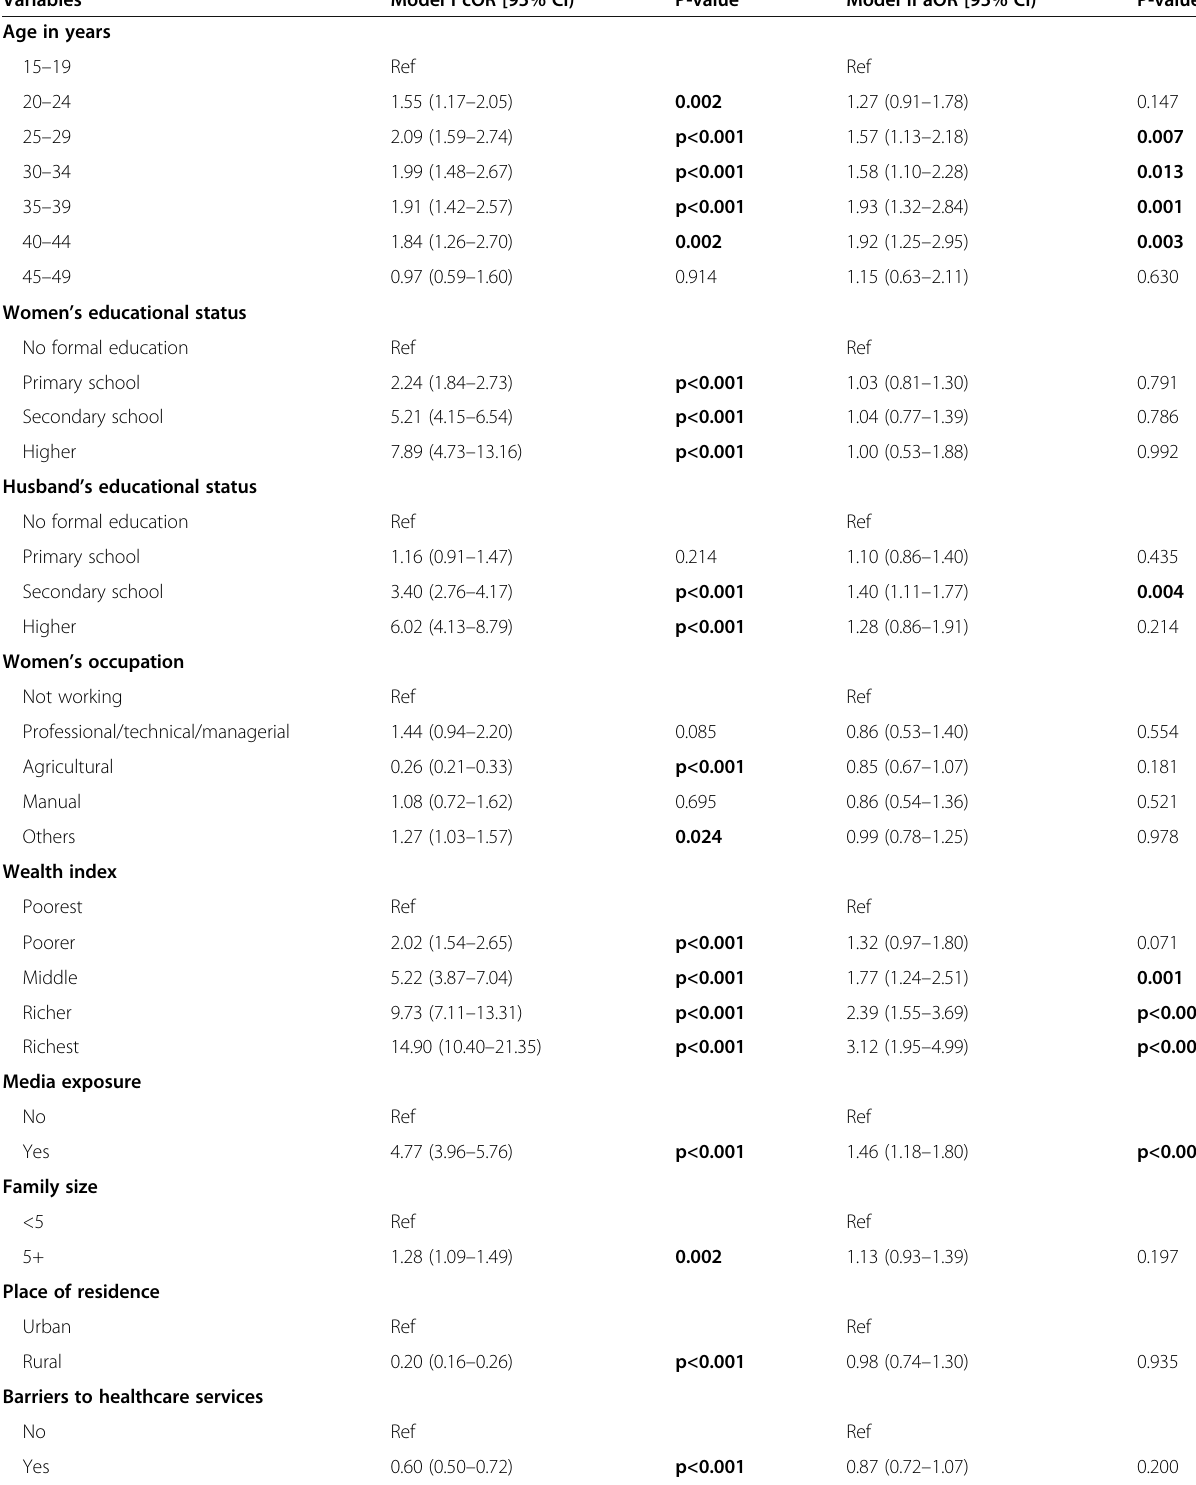
Table 4 Bivariate and multivariable logistic regression output for factors associated with utilization of deworming medication among married women: evidence from 26 SSA countries